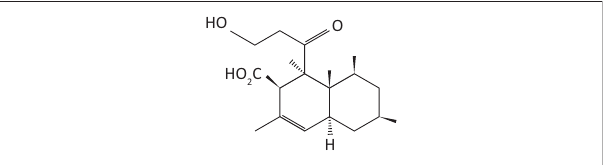
FIGURE 1: The chemical structure of diplodiatoxin purified from Stenocarpella maydis -infected maize culture material